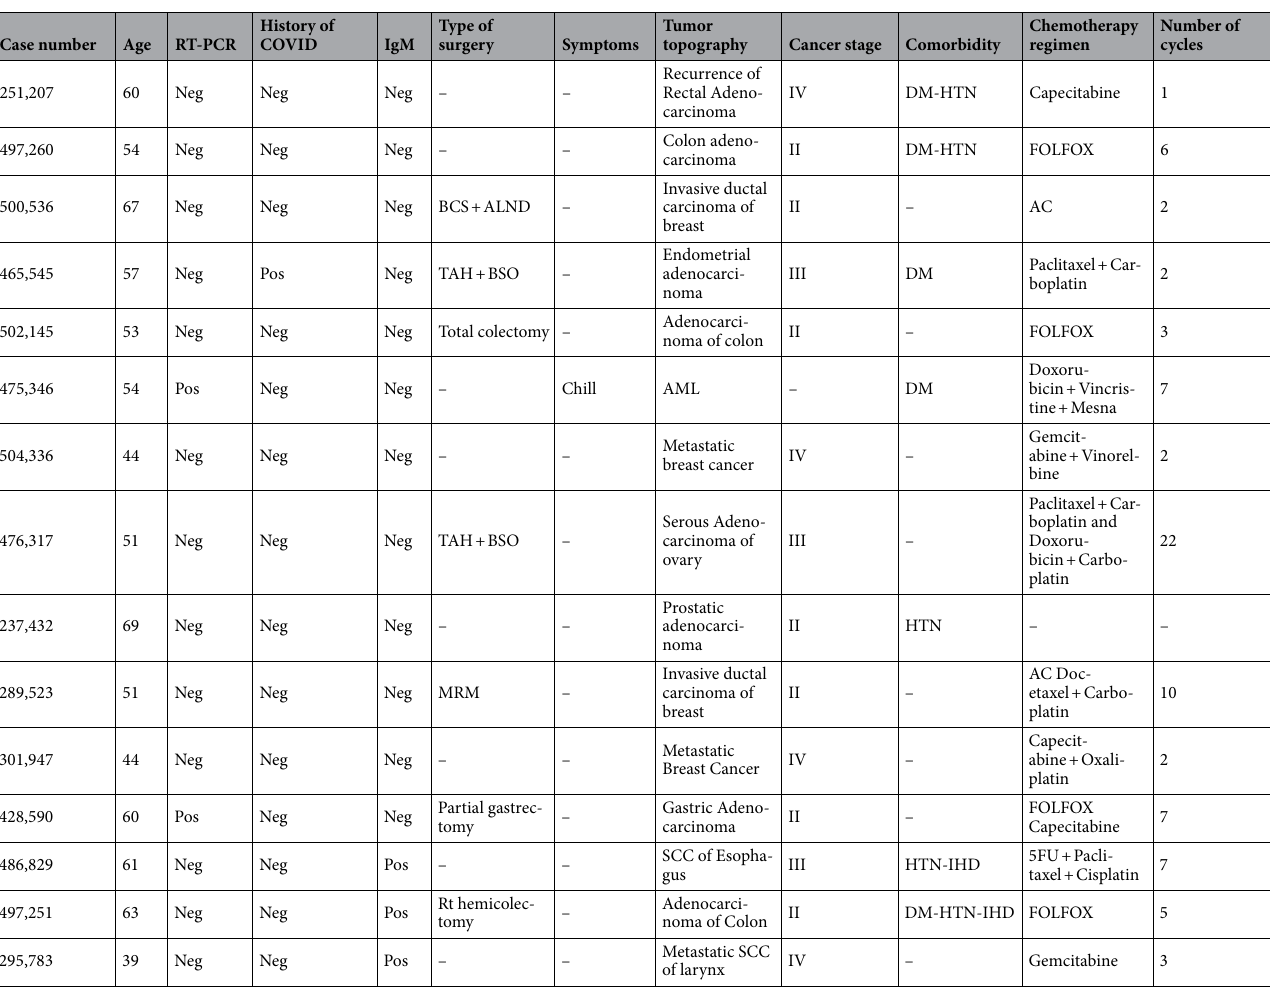
Table 3. Clinical characteristics of cancer patients with history of COVID-19 infection according to IgG serology results.